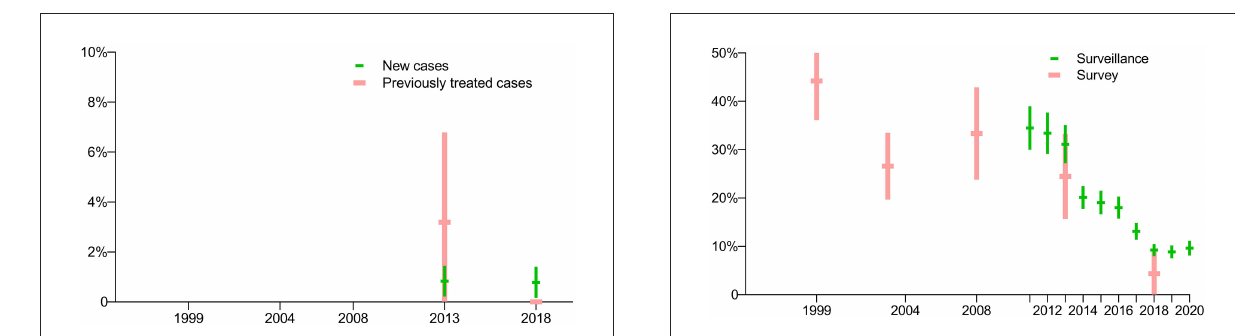
FIGURE6 Comparison of prevalence of rifampin-resistant TB among previously treated cases in periodic surveys and routine